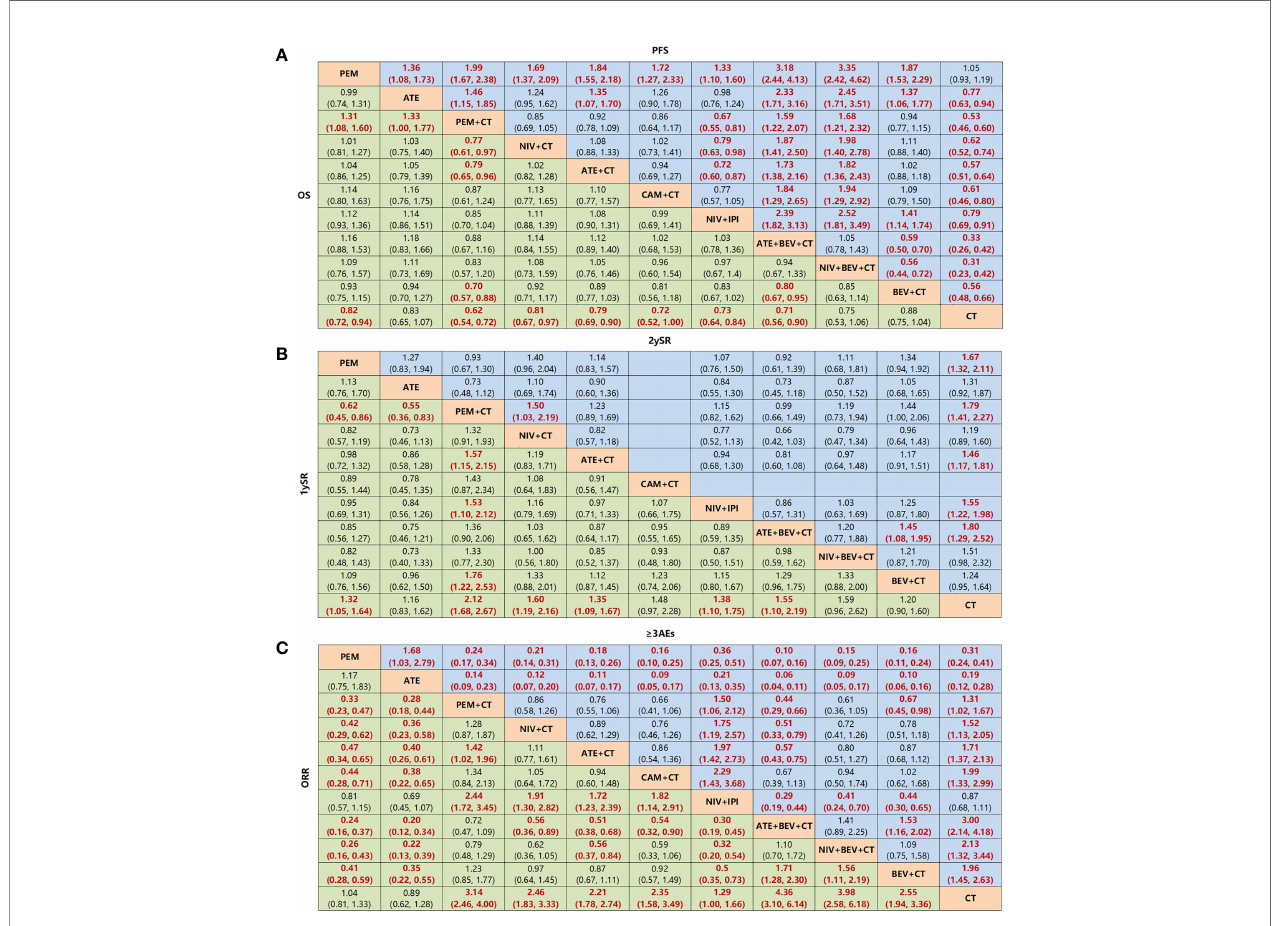
FIGURE 6 | Network meta-analysis of speci fi c immuno-related regimens with long-term survival in overall population. (A) Pooled HR (95% CrIs) for overall survival (OS) and progression-free survival (PFS) in comparisons of all treatment strategies. (B) Pooled OR (95% CrIs) for 1-year survival rate and 2-year survival rate in comparisons of all treatment strategies. Data in each cell are HR or (95% CrIs) for the comparison of row-de fi ning treatment versus column-de fi ning treatment. HR less than 1 and OR more than 1 favor upper-row treatment. Signi fi cant results are highlighted in red and bold. (C) Pooled OR (95% CrIs) for ORR and ≥ 3 AEs in comparisons of all treatment strategies. PEM, pembrolizumab; ATE, atezolizumab; NIV, nivolumab; CAM, camrelizumab; CEM, cemiplimab; BEV, bevacizumab; IPI, ipilimumab, CT,